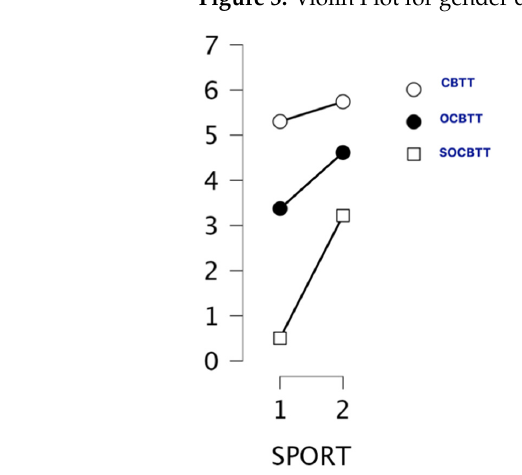
Figure 3. Violin Plot for gender difference and Span expressed in CBTT, OCBTT and SOCBTT.